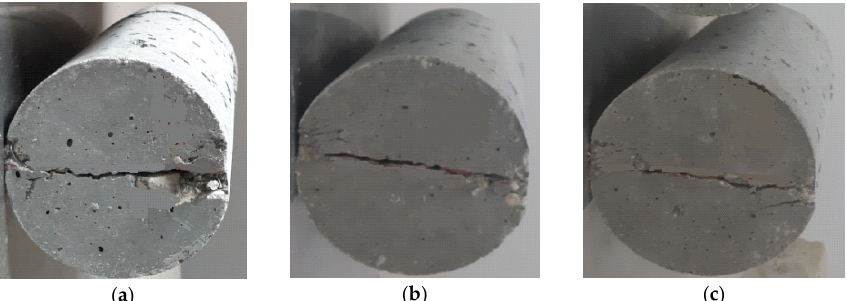
Figure 7. Failure in specimens due to tensile stress in the case of: ( a ) without RTA and PF; ( b ) without PF and with 20% RTA and; ( c ) with 2% PF and without RTA.